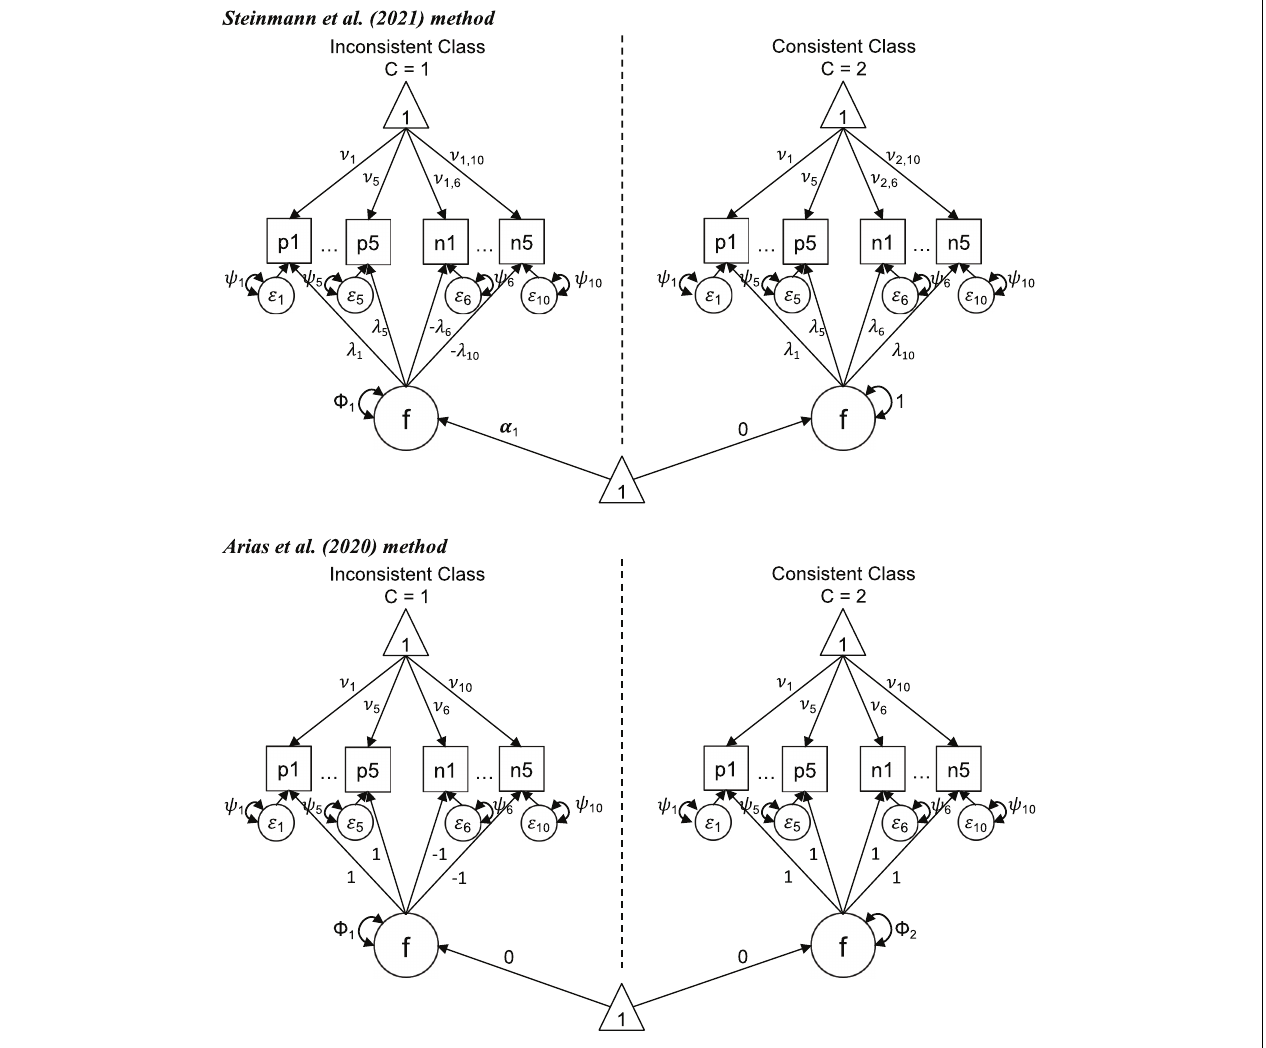
FIGURE 1 | Constrained factor mixture analysis models for the Rosenberg Self-Esteem Scale. p1–p5, positively worded items; n1–n5, recoded negatively worded items; f, factor; ε , residual; ν , item intercept; λ , item factor loading; ψ , item uniqueness; (cid:56) , factor variance; and α , factor